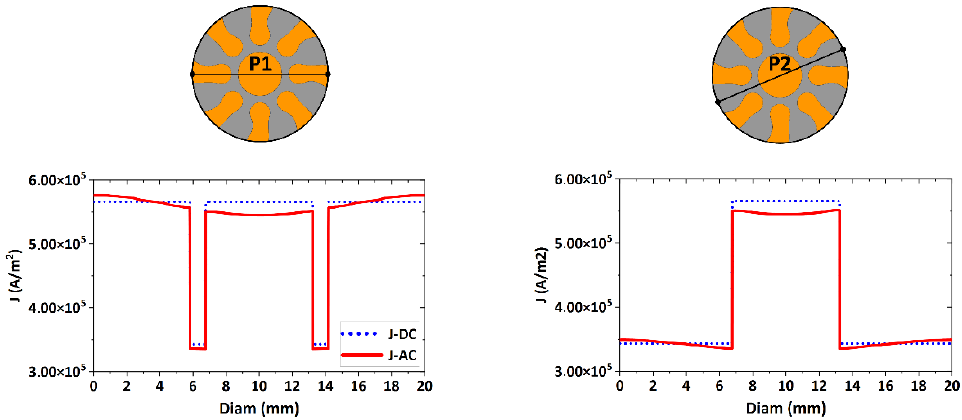
Figure 5. Numerically predicted distributions of current density across cross-sections of 10 mm, 15 mm, and 20 mm swaged composite conductors (cross-sectional composites’ geometries based on experimental observations).